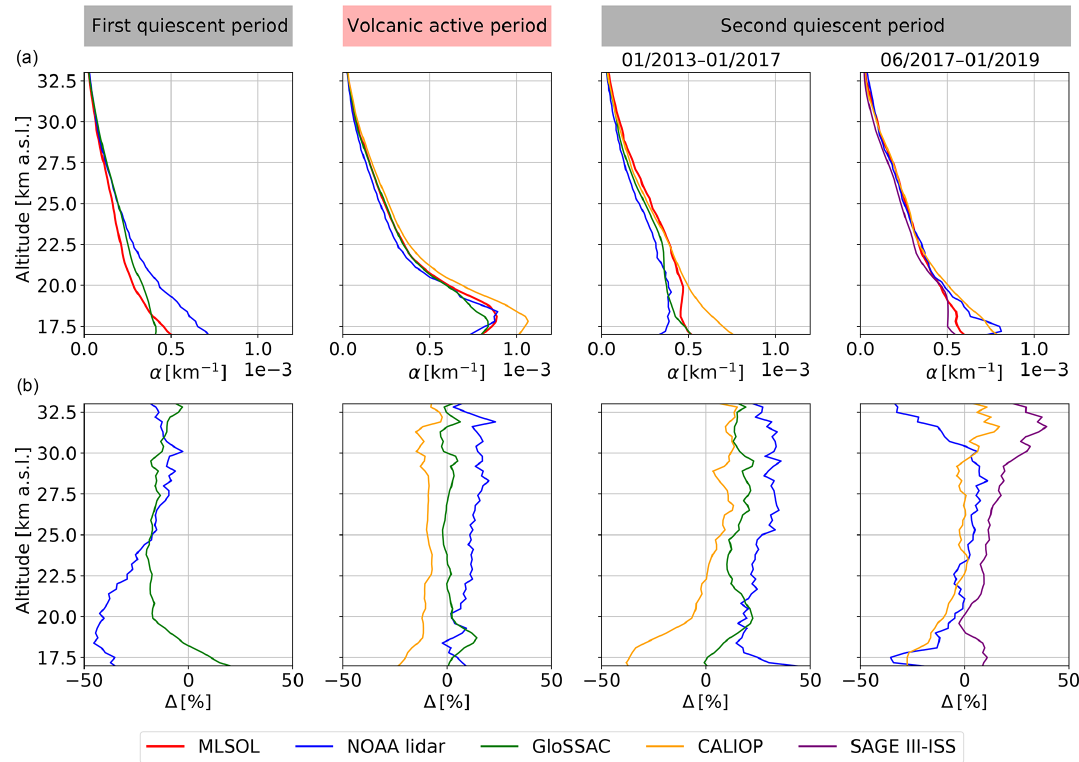
Figure 13. Temporally averaged extinction coefficient profiles at 532nm for the three pre-defined periods (a) presented together with the mean relative difference between MLSOL and each other available dataset for each period (b) . The mean relative difference is calculated as in Fig. 12. In the case of the second quiescent period, the average is split in two sections to take into account the partial temporal coverage of GloSSAC (only the first half) and SAGE III (only the second half).